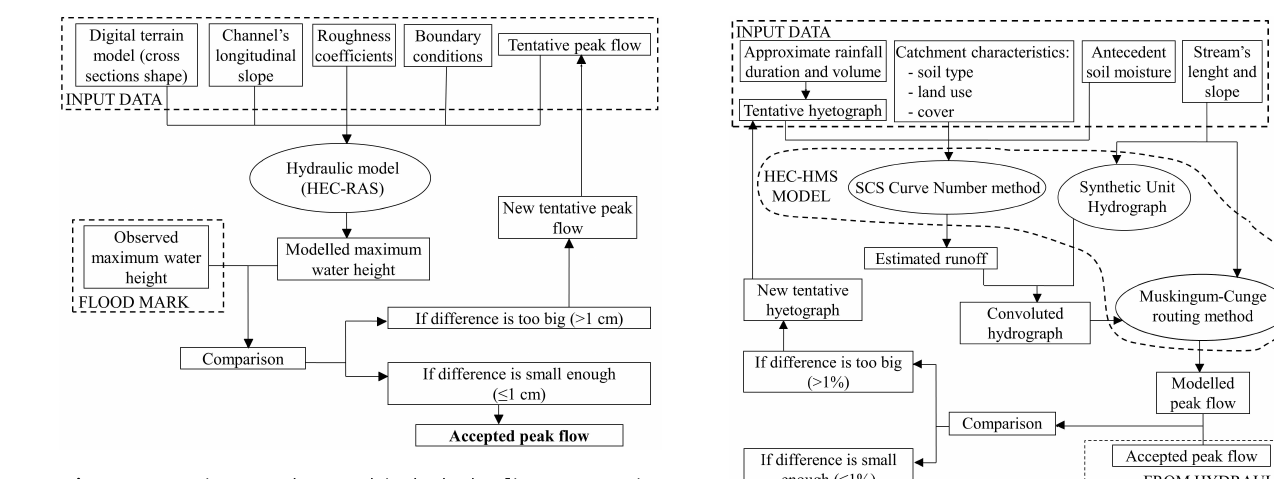
Figure 5. Iterative procedure used in the hydraulic reconstruction of peak flows (modified from Balasch et al., 2010b).